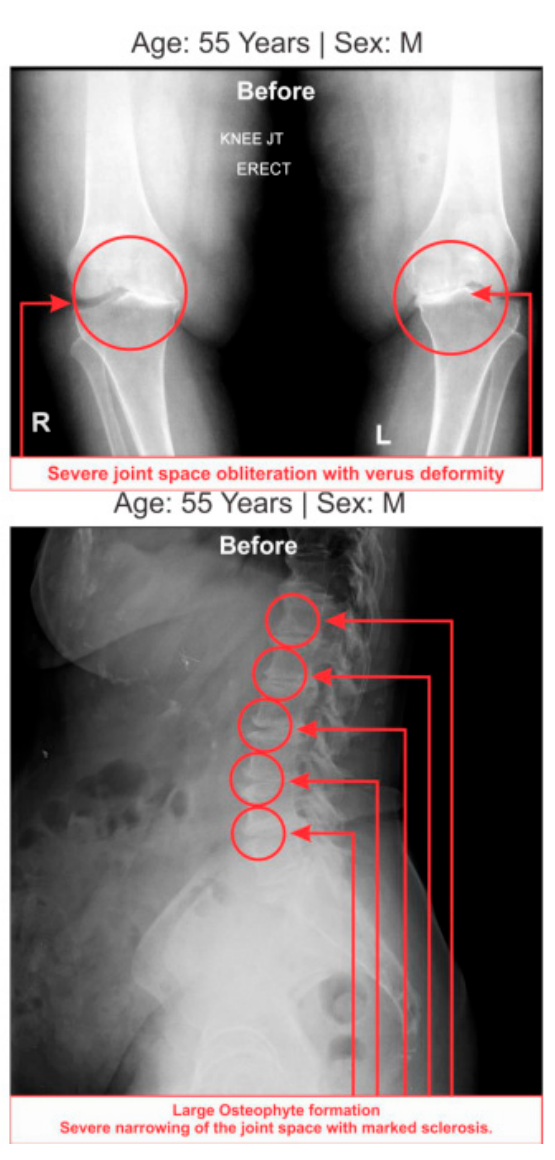
Figure 7. Radiological images of a patient suffering with lumbar herniated disc with knee-osteoarthritis (LHD-KOA).